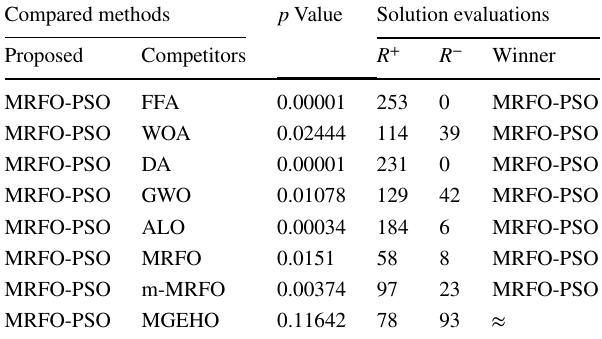
Table 10 Wilcoxon’s test for the studied cases of the lithium-ion bat-